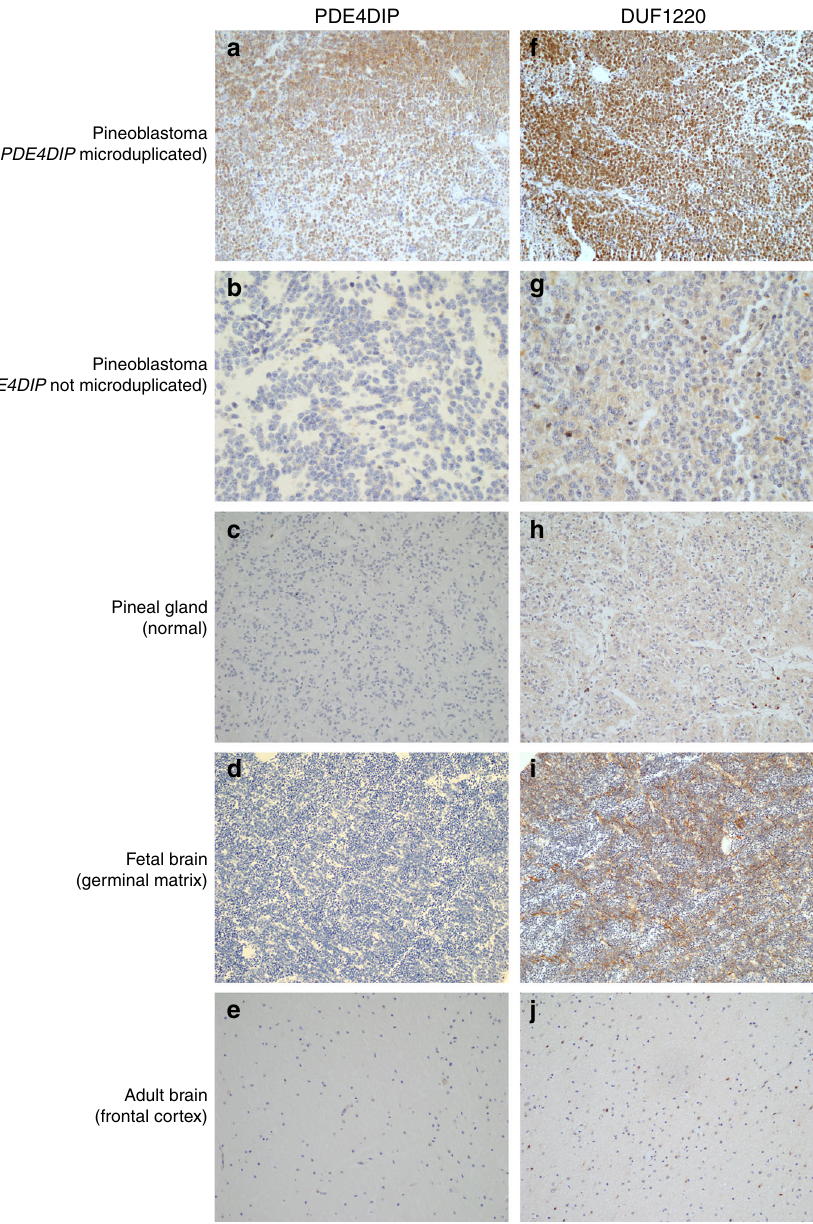
Fig. 4 PDE4DIP microduplication correlates with overexpression of DUF1220. Pineoblastomas with PDE4DIP microduplication ( n = 7) show strong expression of both PDE4DIP protein ( a ), as well as DF1220 protein ( f ), while pineoblastomas with no PDE4DIP microduplication ( n = 5) ( b , g ) and normal pineal gland ( c , h ) are negative for both proteins. DUF1220 is strongly expressed in the germinal matrix of the fetal brain ( i ), consistent with its established role in human brain development; however, fetal brain neuroblasts are completely negative for PDE4DIP expression ( d ). Adult brain tissue is negative for both PDE4DIP and DUF1220 protein expression ( e , j ). ( n = 5 for each normal control group, original magni fi cation 400×, Scale bar 100 µ